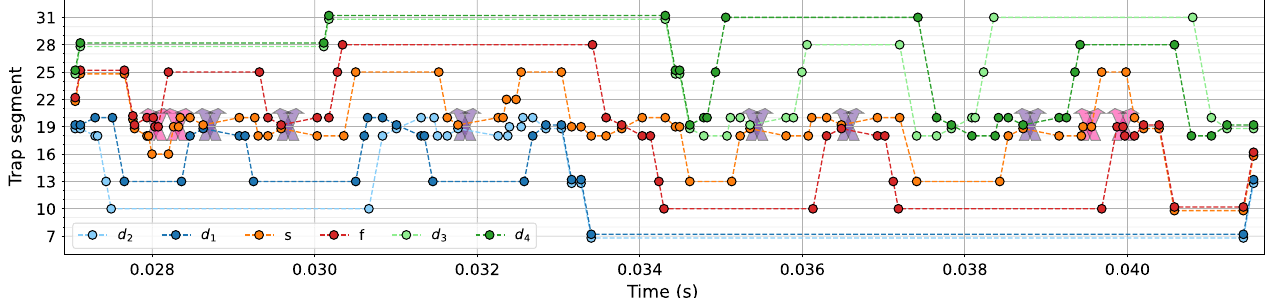
FIG. 3. Shuttling schedule of the fault-tolerant parity readout measurement sequence indicating how the ion qubits are moved between different storage sites of the segmented ion trap. The fixed laser interaction zone is located at segment 19. The arrows indicate laser- driven gate interactions. A distance of at minimum two empty segments between sets of ion qubits is maintained throughout the sequence. The maximum spatial extent of the register is 24 segments (4.8